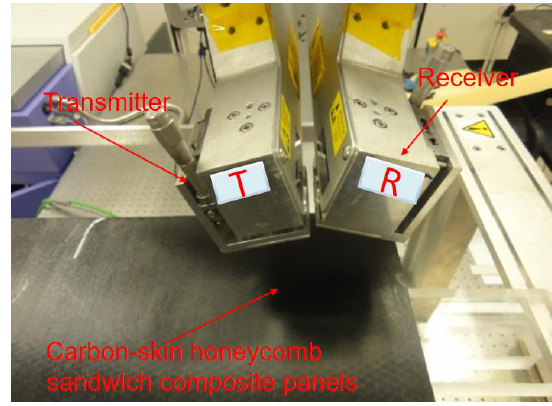
Figure 2. A photo of a T-ray system for measuring and imaging material properties under reflection mode.